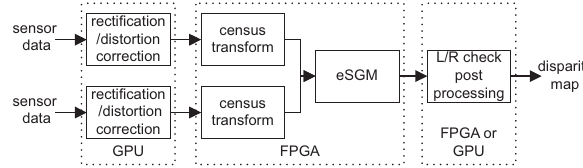
Figure 5: Overview of the functional blocks and the underlying heterogeneous hardware